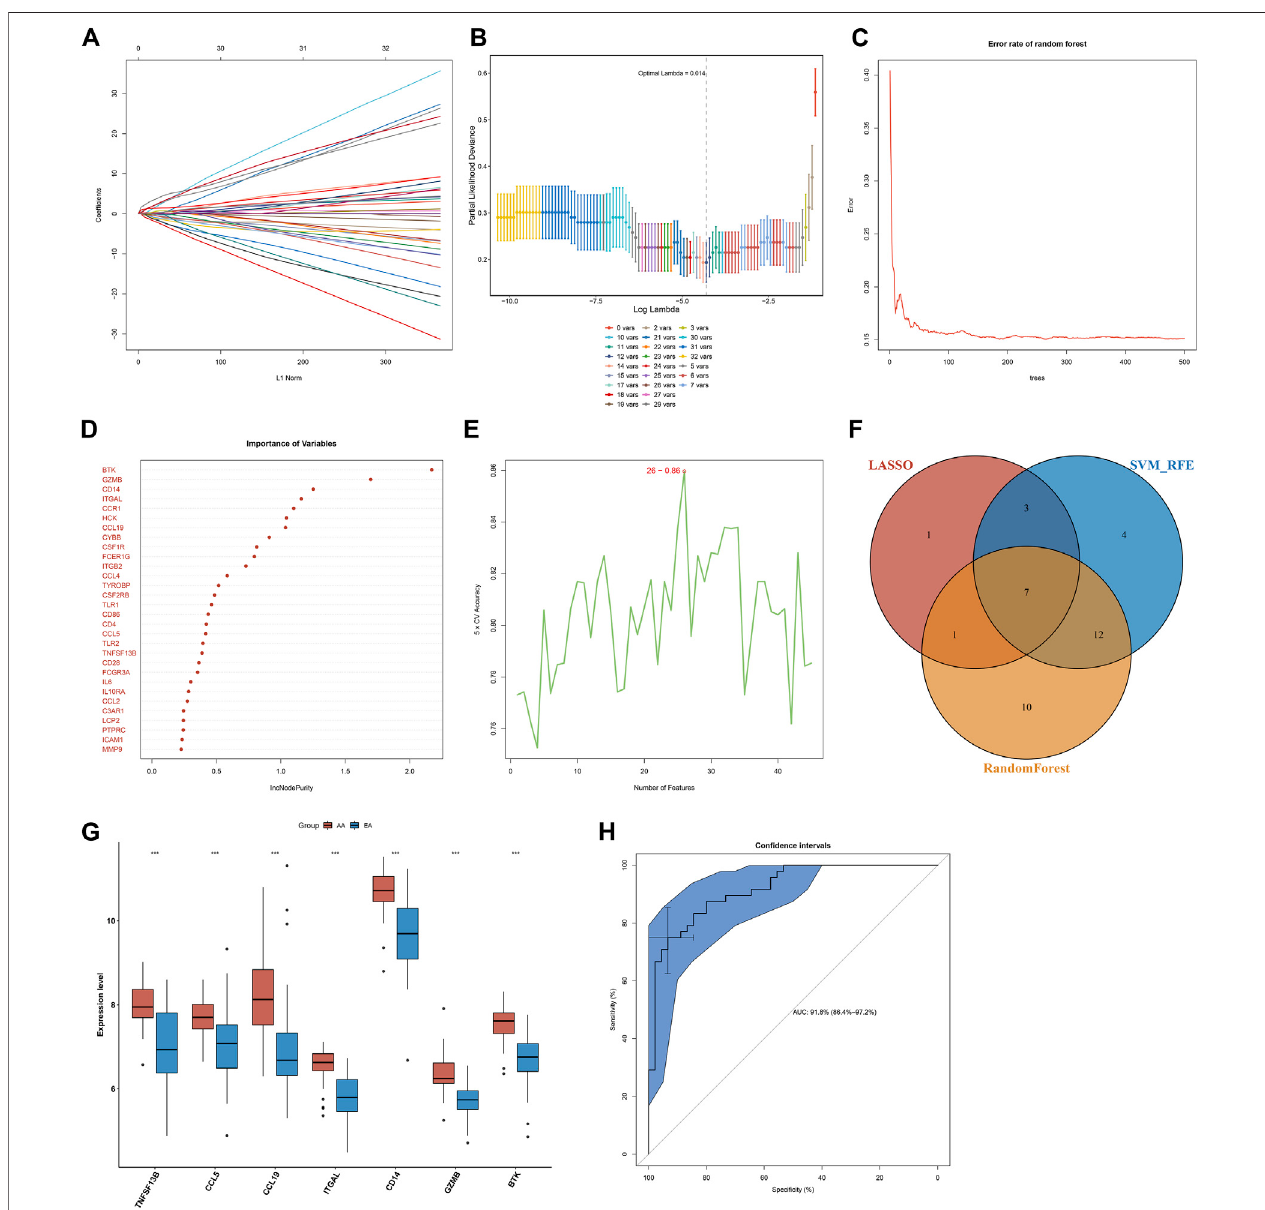
FIGURE 3 | Selection of characteristic genes among key atherosclerotic plaque progression- and immune-associated genes and estimation of their diagnostic ef fi cacy in the combined GSE28829 and GSE43292 datasets. (A) Ten-time cross-veri fi cation for tuning parameter selection in the LASSO model. Each curve corresponds to a single gene. (B) LASSO coef fi cient pro fi ling. The solid vertical lines represent the partial likelihood deviance SE. The dotted vertical line is drawn at the optimal lambda. (C) Random forest for the relationships between the number of trees and error rate. (D) The rank of genes in accordance with their relative importance. (E) SVM-RFE algorithm for feature selection. (F) Venn diagram showing the characteristic genes shared by LASSO, random forest, and SVM-RFE algorithms. (G) Box plots depicting the mRNA expression of characteristic genes in early-stage and advanced-stage atherosclerotic plaques. AA: advanced-stage atherosclerotic plaque; EA: early-stage atherosclerotic plaques. *** p < 0.001. (H) The ROC curves estimating the diagnostic performance of characteristic genes.